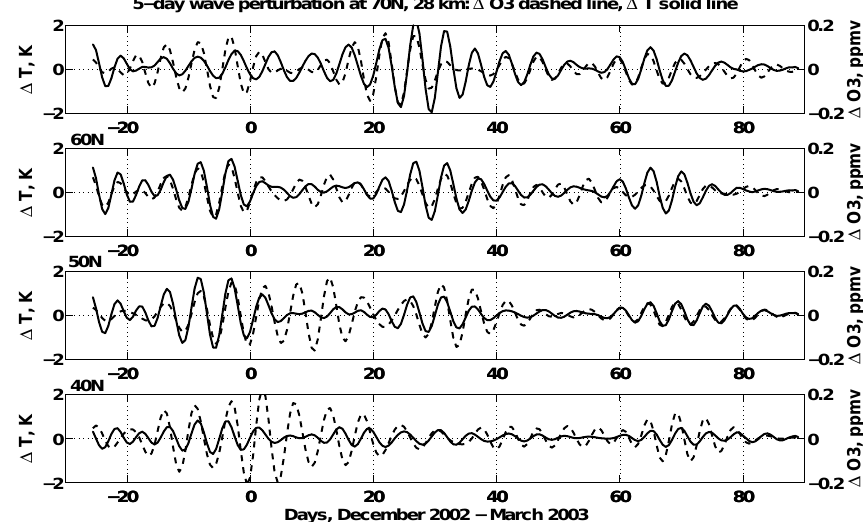
Fig. 8. The 5-day wave perturbation in temperature (left scale, K) and ozone (right scale, ppmv) at 28km from Odin SMR data at 70 ◦ N, 60 ◦ N, 50 ◦ N, 40 ◦ N.